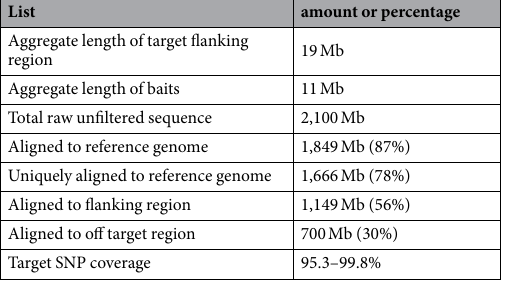
Table 1. Detailed description of sequences generated from catches.